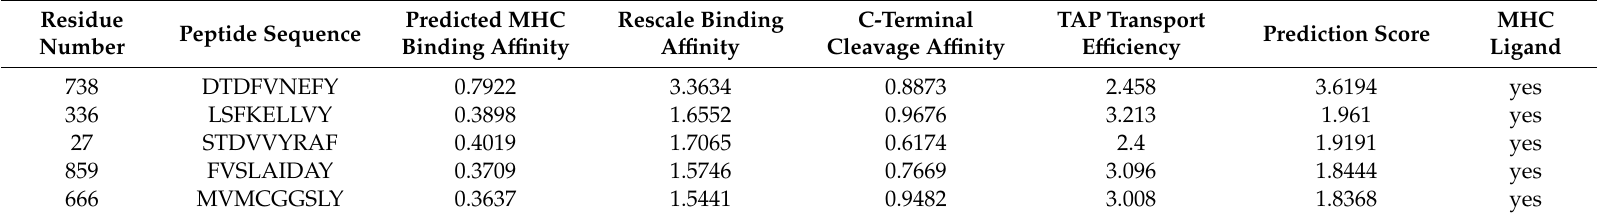
Table 7. Predicted CTL from SARS-CoV-2 Nsp12 RdRp